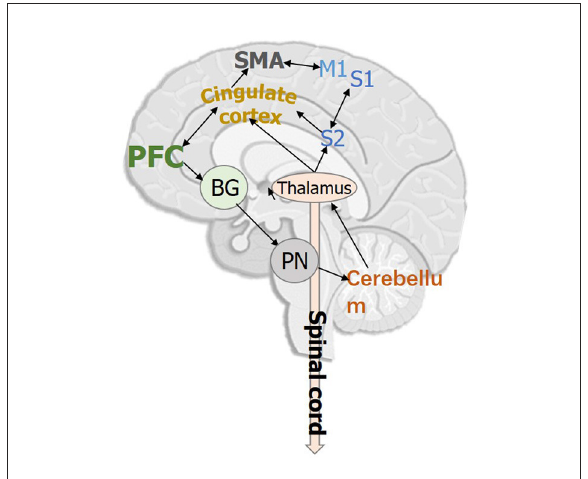
FIGURE1 Key cortical and subcortical brain regions that are involved in human bipedal gait. PFC, Prefrontal cortex; M1, Primary motor cortex; S1/S2, Primary/Secondary somatosensory cortex; SMA, Supplementary motor area; BG, Basal ganglia; PN, Pontine